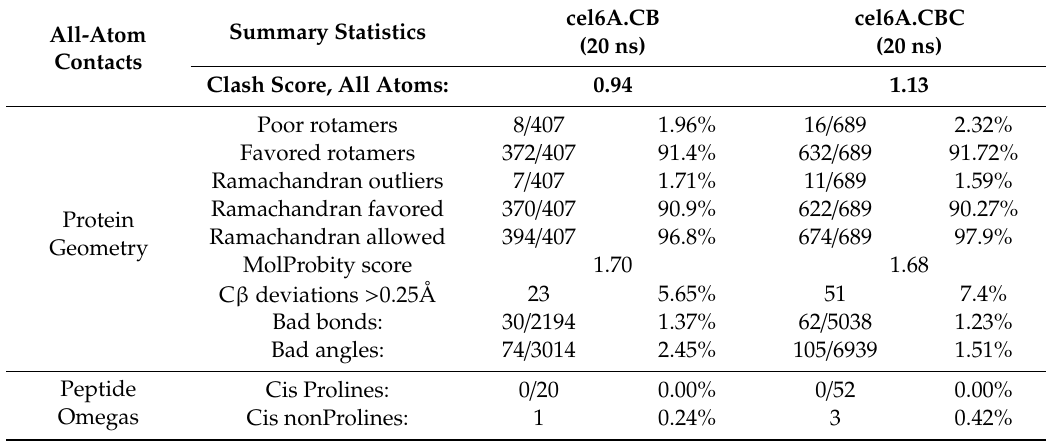
Table 2. Summary statistics of all-atom contacts and stereochemistry of cel6A.CB and cel6A.CBC after refinement through molecular dynamics (MD)